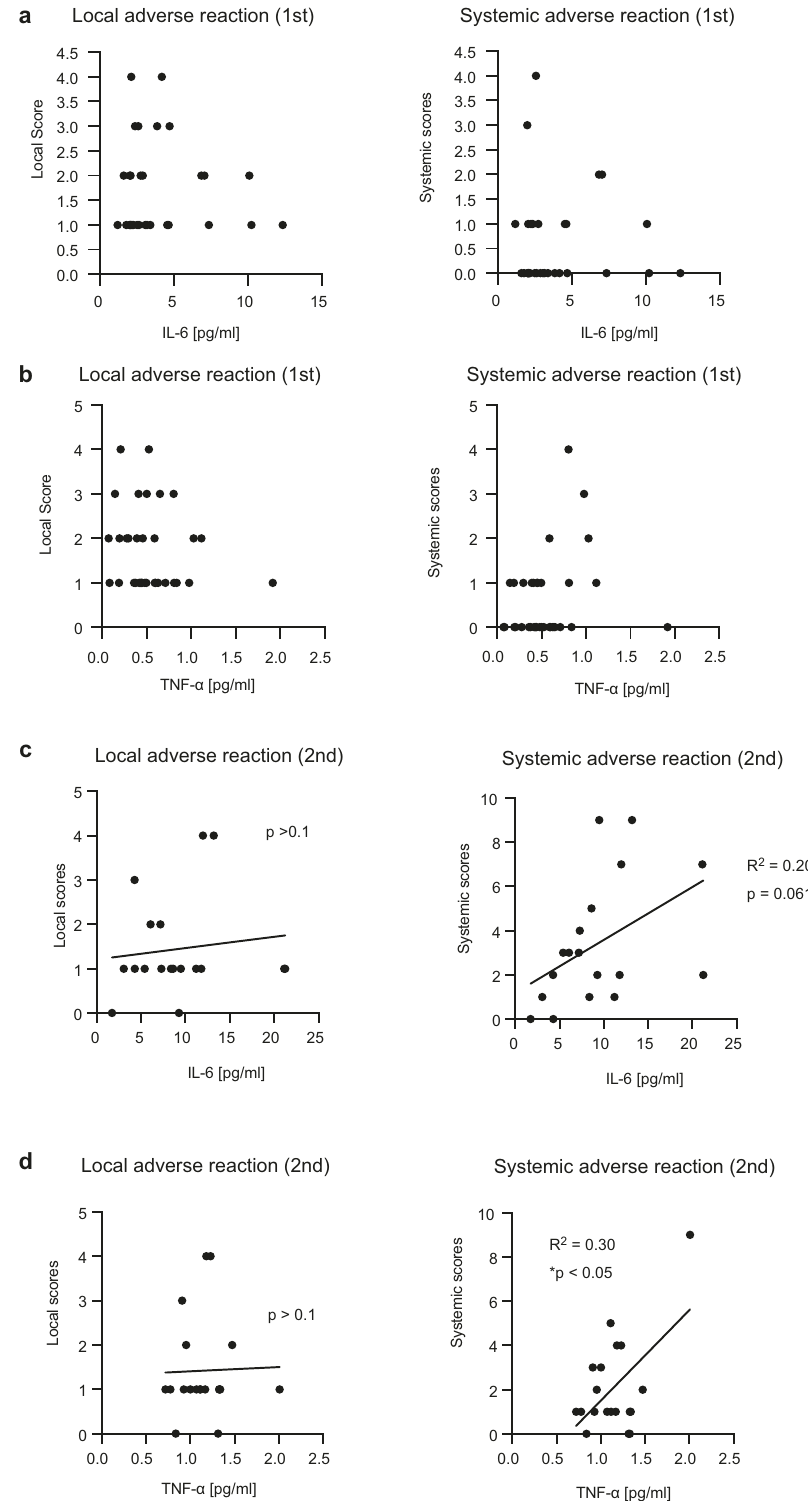
Fig. 4 Correlation between cytokine level and degree of symptoms. a , b Local and systemic scores were compared with serum IL-6 ( a ) and TNF- α ( b ) levels 1 day after the fi rst dose. There were no correlations. c , d Local and systemic scores were compared with serum IL-6 ( c ) and TNF- α ( d ) levels 1 day after the second dose. The coef fi cient of determination (R 2 ) and p -values were calculated (Pearson correlation test, * p < 0.05). Each dot represents a